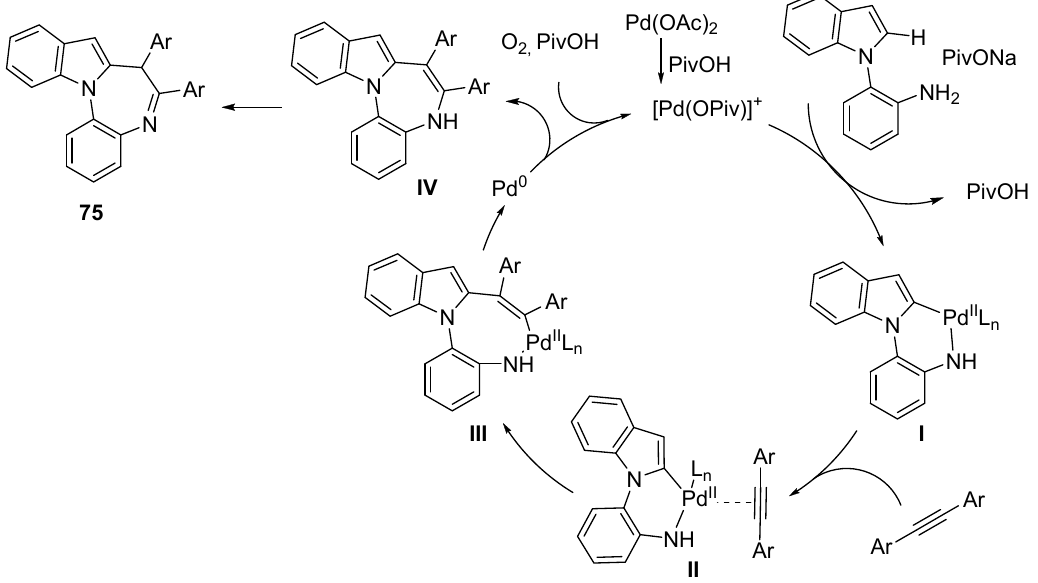
Scheme 37. Proposed mechanism for the synthesis of 1,2-fused indole-diazepines 75 .